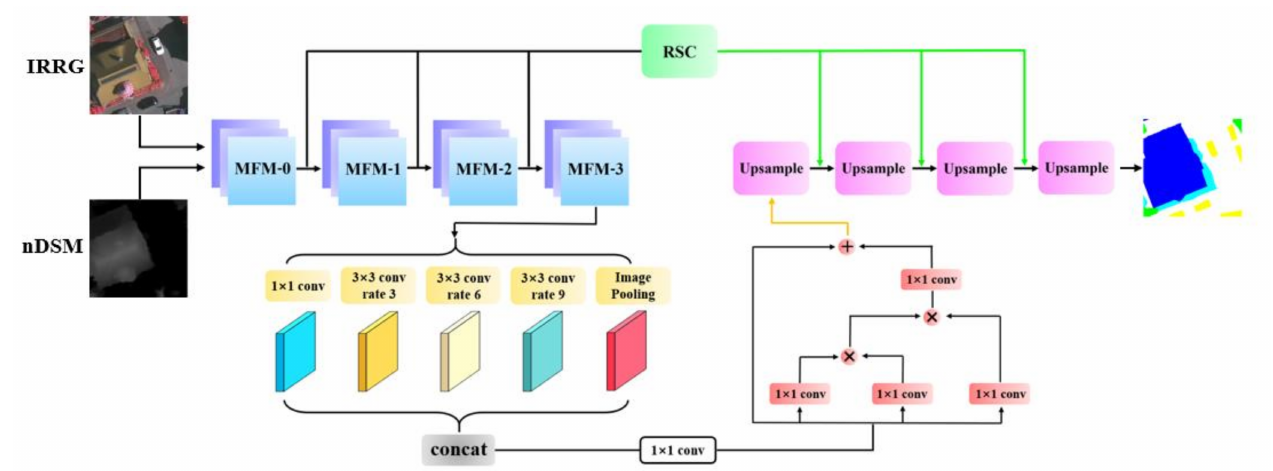
Figure 2. The overall architecture of